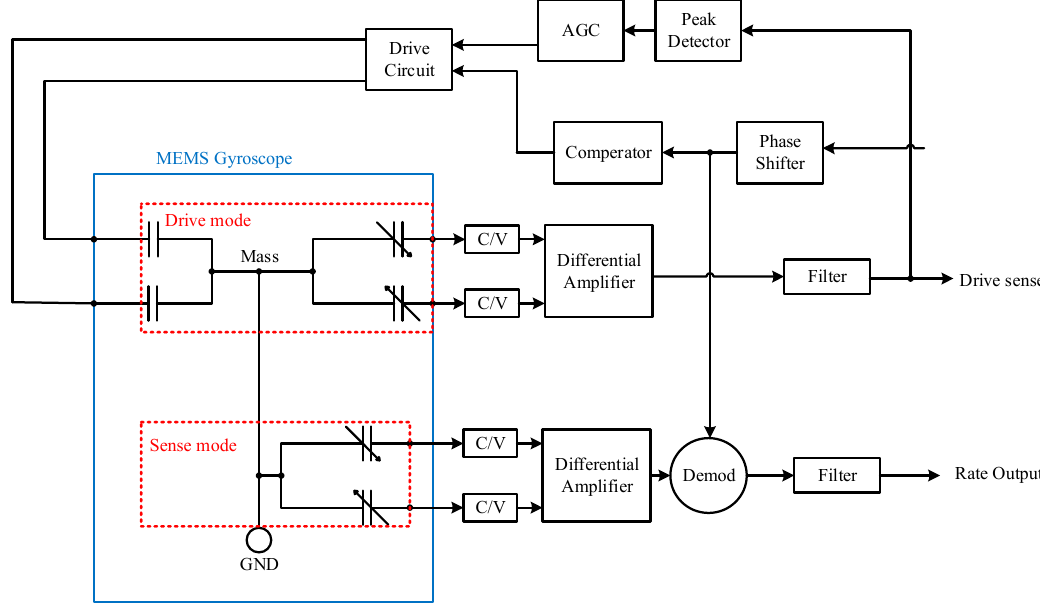
Figure 8. Circuit block diagram.